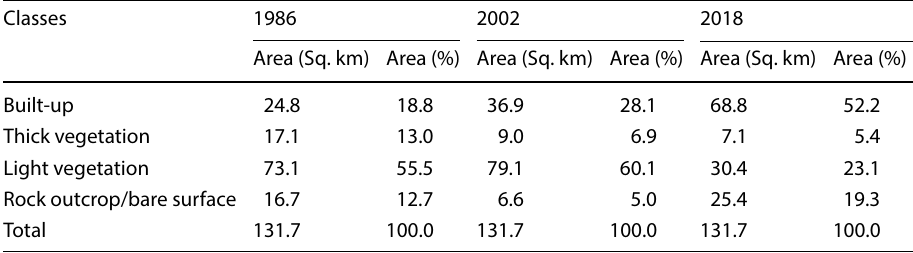
Table 2 Land use land cover of the study area for 1986, 2002 and